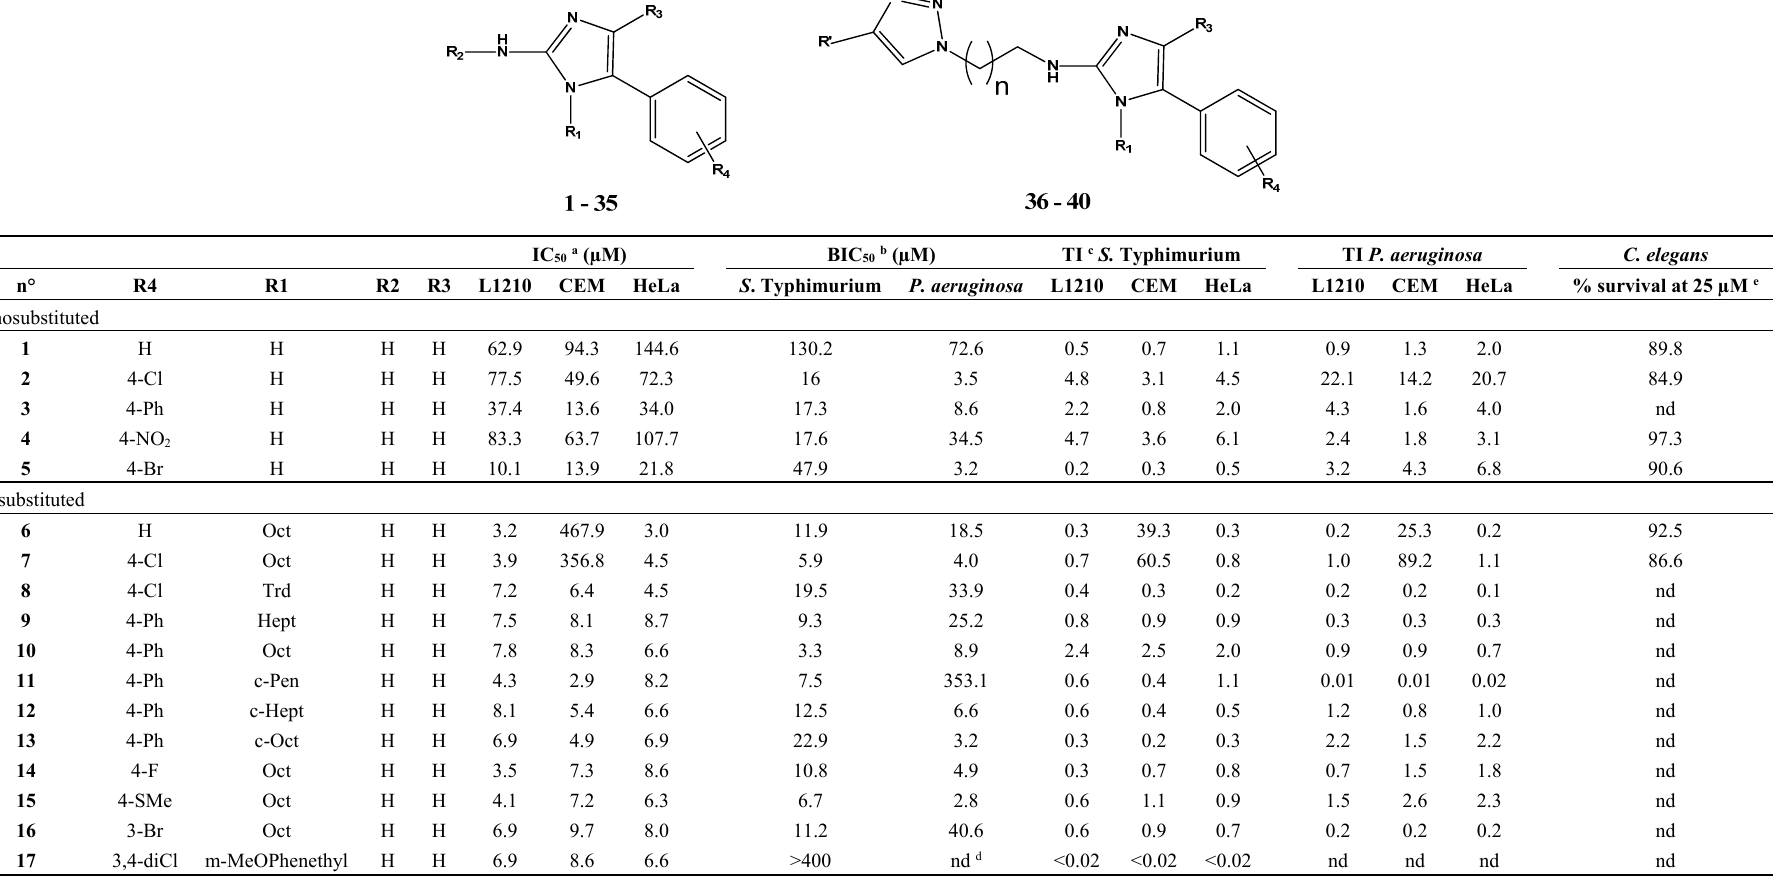
Table 1. Cytostatic activity of 5-Ar-2AI subclasses against tumor cell lines, toxicity against C. elegans and anti-biofilm activity against bacterial